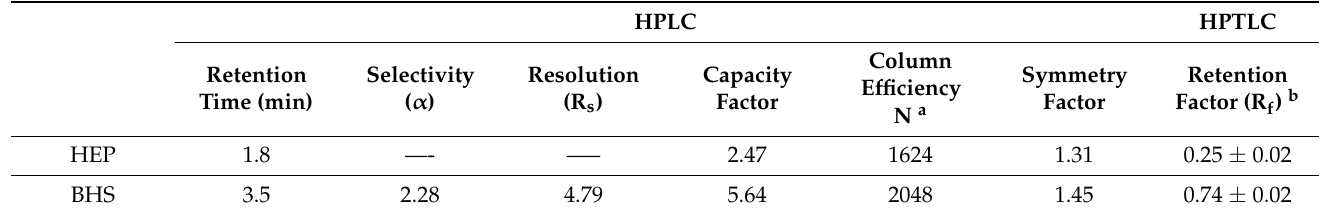
Table 1. Chromatographic separation parameters and system suitability of the proposed methods. HPLC